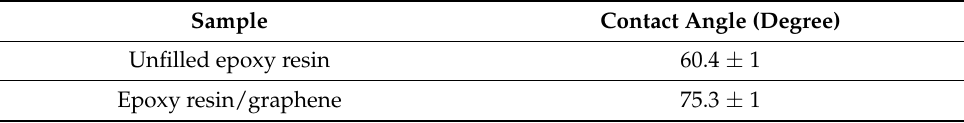
Table 2. Water contact angle values for graphene-filled and unfilled epoxy resin. Reprinted with permission from [108]. 2021, MDPI.